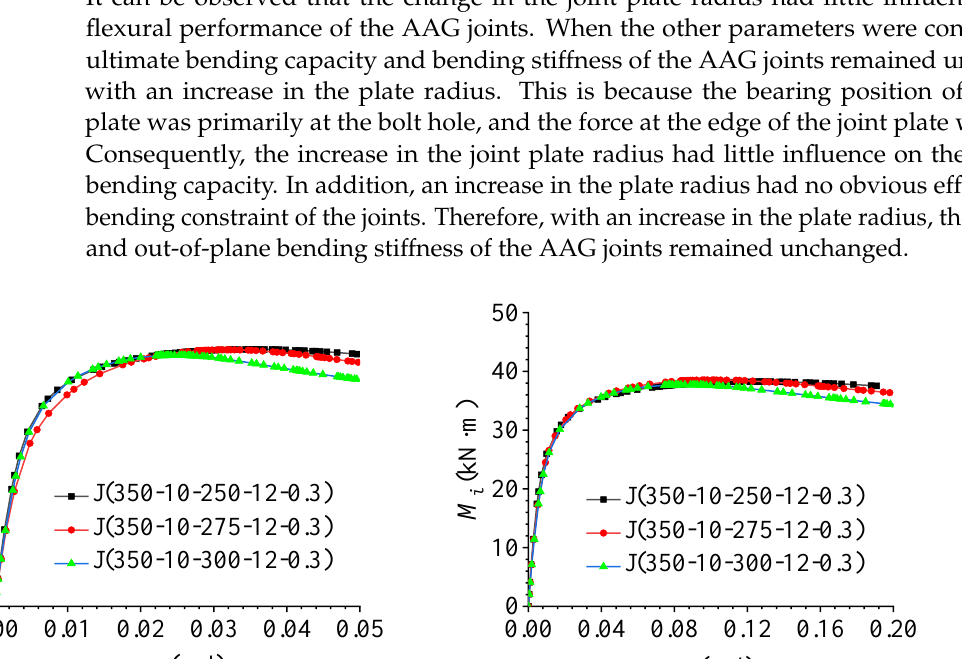
Figure 16. Stress clouds and plastic strain maps of J(350-11-275-12-0.3). ( a ) Stress cloud of member; ( b ) stress cloud of joint plates; ( c ) stress cloud of bolts; ( d ) plastic strain of member; ( e ) plastic strain of joint plates; ( f ) plastic strain of bolts.